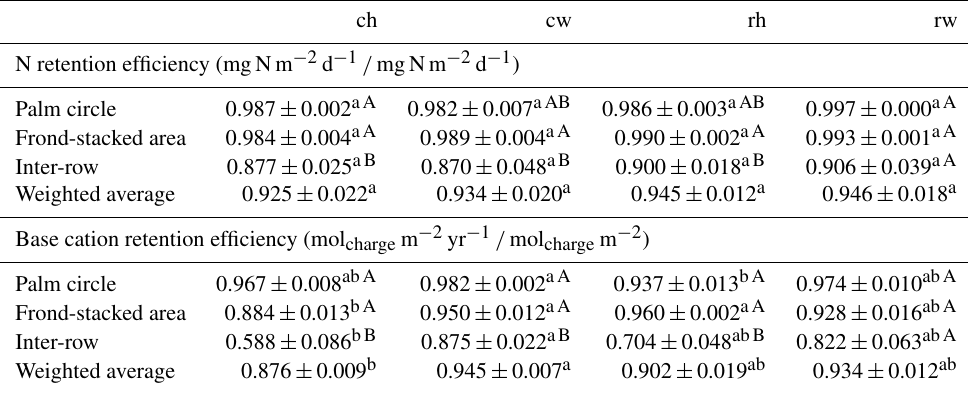
Table 4. N and base cation retention efficiencies in the soil for each management zone and experimental treatment (means ± standard er- rors, n = 4 plots). Means followed by different lowercase letters indicate differences among experimental treatments for each management zone, whereas different uppercase letters indicate differences among management zones for each experimental treatment (one-way ANOVA with the Tukey HSD or Kruskal–Wallis H test with multiple comparison extensions at P ≤ 0 . 05). Weighted average is based on the areal coverage of each management zone: 18% for palm circle, 15% for frond-stacked, and 67% for inter-row areas. Treatments: ch is conven- tional fertilization–herbicide, cw is conventional fertilization–mechanical weeding, rh is reduced fertilization–herbicide, and rw is reduced fertilization–mechanical weeding. See Sect. 2.4 for calculations of N and base cation retention efficiency.